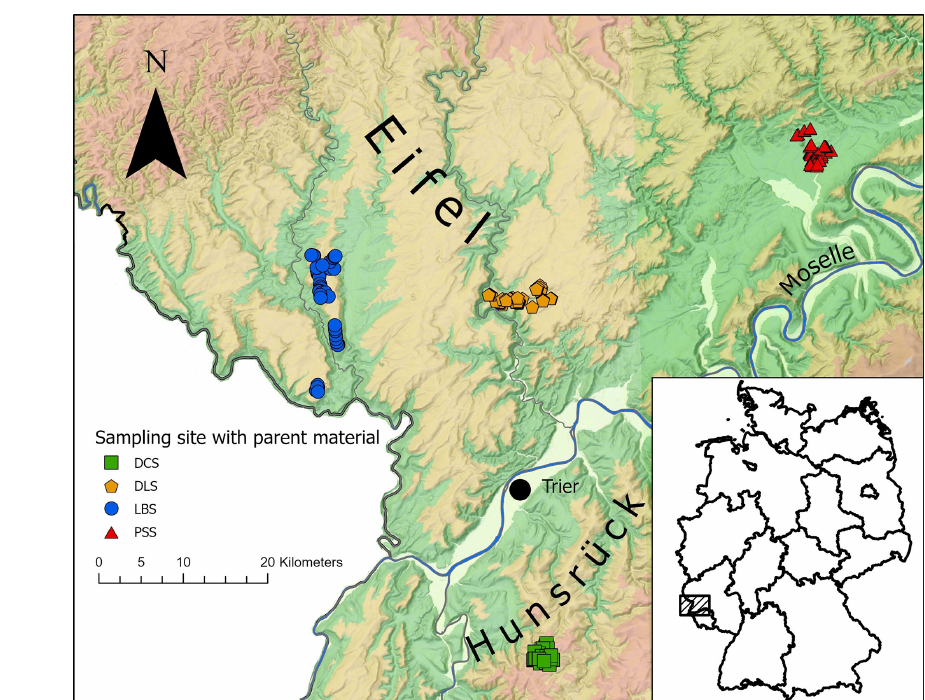
Figure 1. Study area in the greater Trier region; sampling sites in the four regions with different parent material are indicated, i.e. Devonian clay schist (DCS), sandy dolomitic limestone (DLS) from the Muschelkalk, Luxembourg sandstone (LBS), and Permian siltstone and fine sandstone (PSS) from the Rotliegend (©